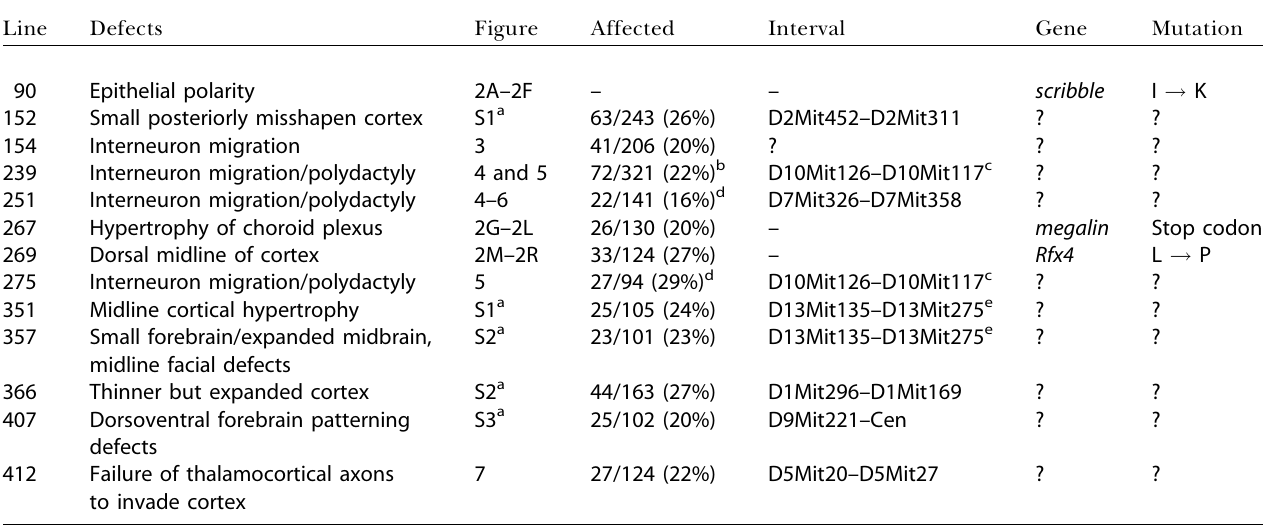
Table 1. Summary of Cortical Mutants Line